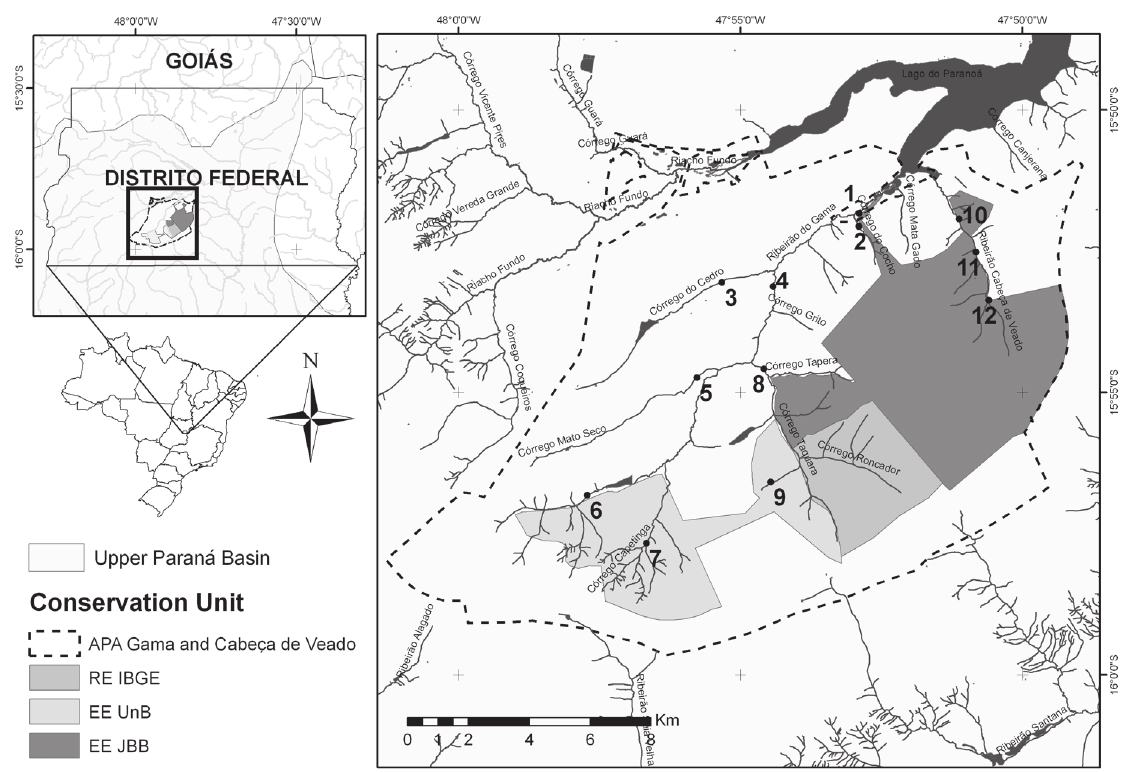
Fig. 1. Location of sampled stretches in the Gama sub-basin (1 to 9) and Ribeirão Cabeça de Veado (10 to 12). Represented in gray scales are the main integral protection conservation units (RE IBGE - Reserva Ecológica do IBGE, EE UnB - Estação Ecológica da UnB, EE JBB - Estação Ecológica do Jardim Botânico de Brasília) of APA Gama and Cabeça de